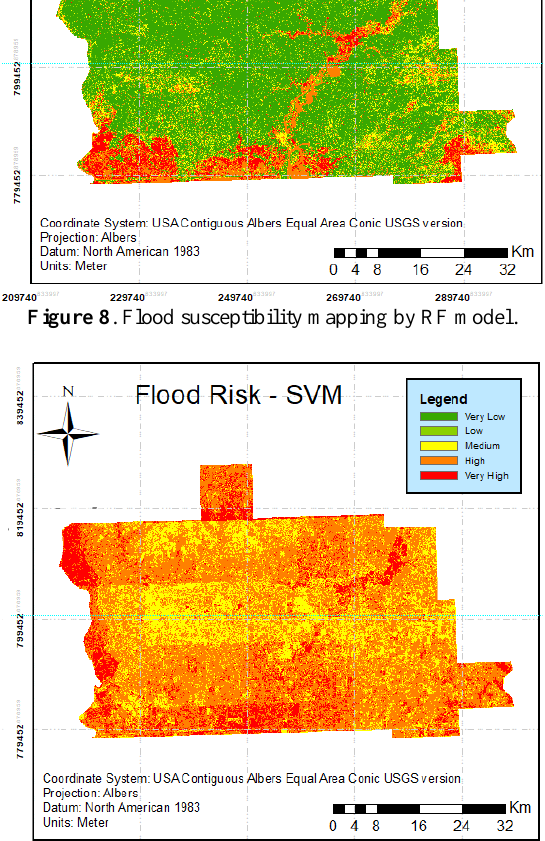
Figure 9 . Flood susceptibility mapping by SVM model.